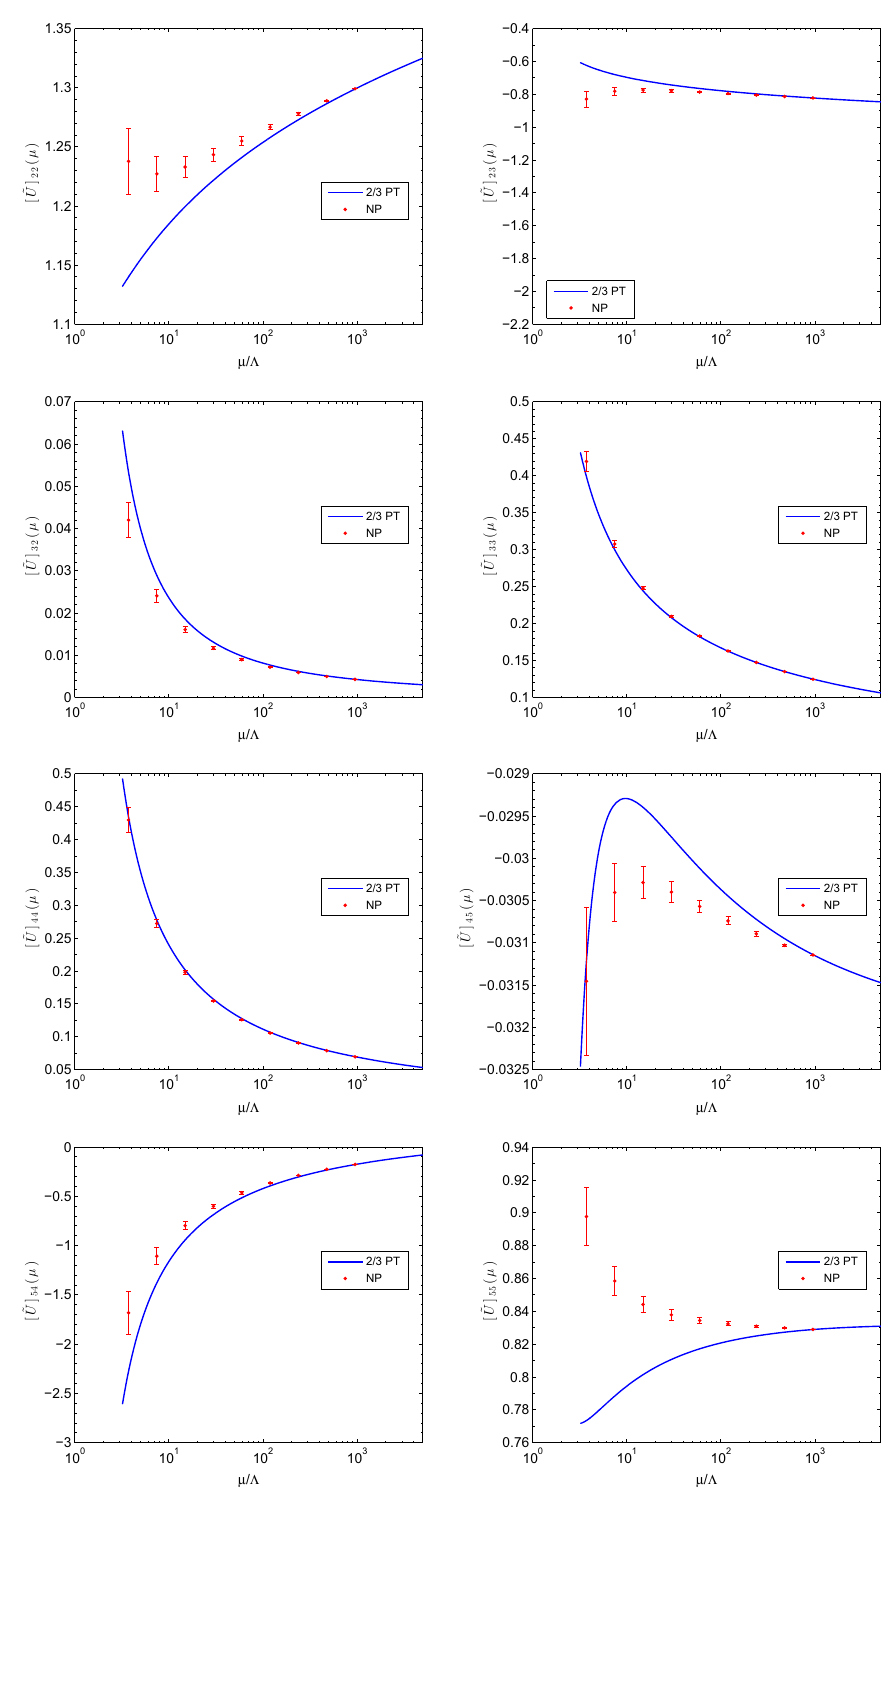
Fig. 9 Non-perturbative (μ) of the running ˜ U − ( 2 , 3 ) , Q − } (top) operator basis { Q − 2 3 (μ) of the operator and ˜ U − ( 4 , 5 ) , Q − } (bottom). basis { Q − 4 5 Results are compared to the perturbative predictions, obtained by numerically integrating Eq. (2.23), with the NLO result for γ and the NNLO one for β , in the SF scheme